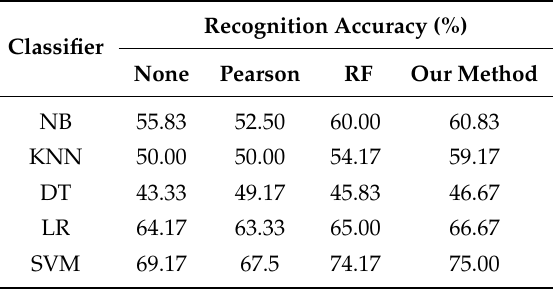
Table 11. Average recognition accuracy of speaker-dependent speech emotion recognition on